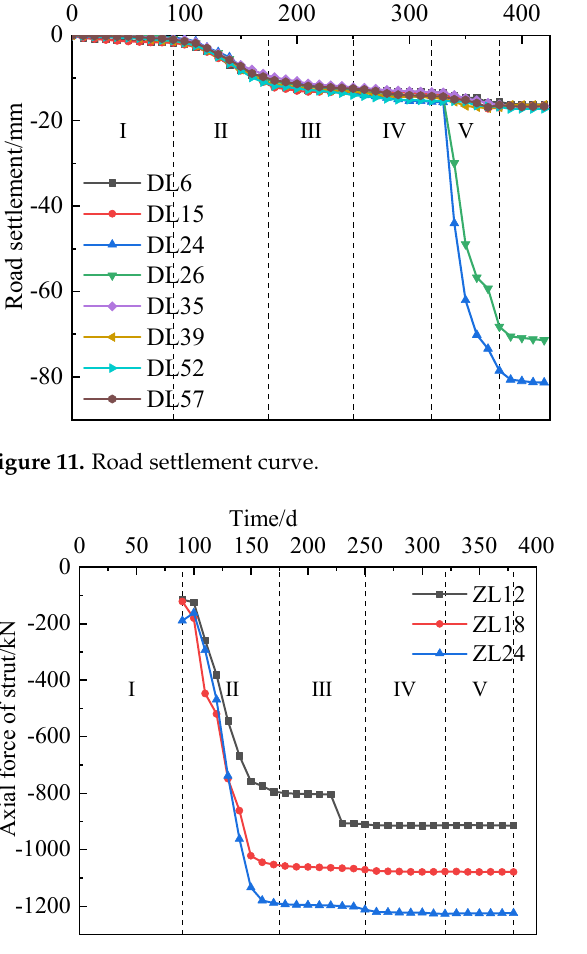
Figure 12. Variation curve of the axial force of the brace.